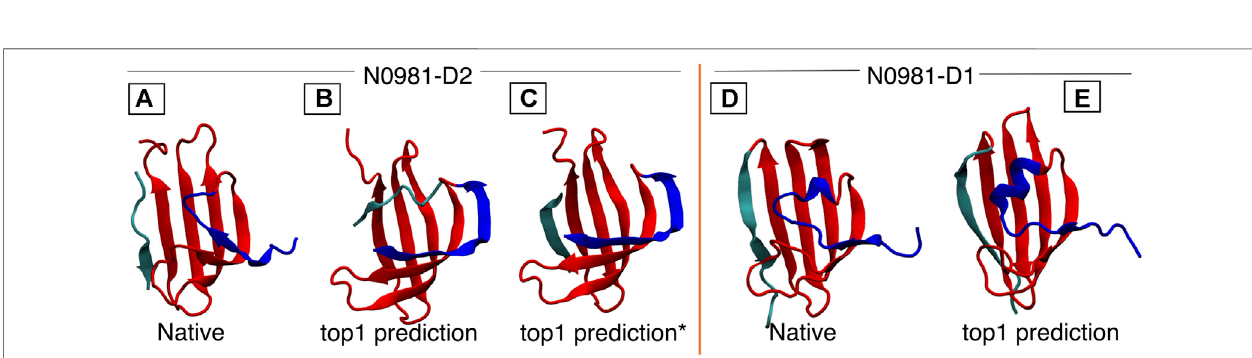
FIGURE 5 | N0981D1 and N0981D2 domains are structurally similar, differing in the N-termini conformation (shown in blue). MELD captures the difference in N-termini conformation, but initial predictions fail for the cyan termini. In N0981D2, this corresponds to an independent fragment, which our standard protocol fails to bind into the main fragment. (A) Native structure for N0981D2. (B) MELD prediction for N0981D2. (C) MELD prediction from a modi fi ed protocol to use two fragments. (D) N0981D1 native structure. (E) MELD prediction for